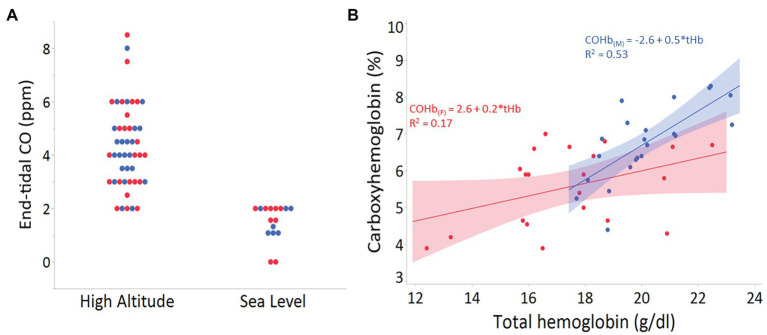
(A) End-tidal carbon monoxide (CO) levels (ppm) in 47 adults from Cerro de Pasco, Peru (high altitude), and 18 adults of mixed ancestry living in San Diego, California, USA (sea level). There was no statistical difference between males (blue) and females (red) from high or low altitude groups (p > 0.8 for both). (B) Relationship between total hemoglobin (g/dl) and the percent carboxyhemoglobin (COHb) in venous blood of adult males (n = 22; blue) and females (n = 21; red) from Cerro de Pasco, Peru (4,330 m).